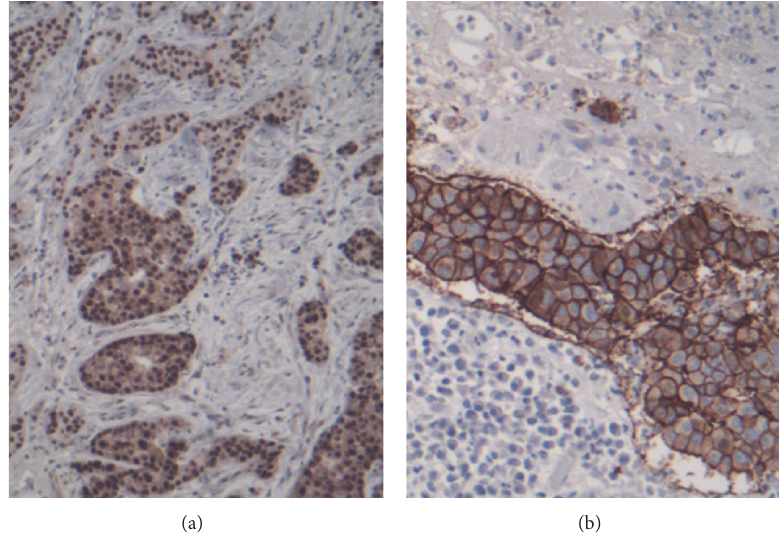
Figure 2: (a) Immunostaining for androgen receptor. Intense nuclear staining in the overwhelming majority of tumor cells. (b) Immunostaining for Human Epidermal growth factor Receptor-2 (HER2). Score 3+. Original magnification: × 100.